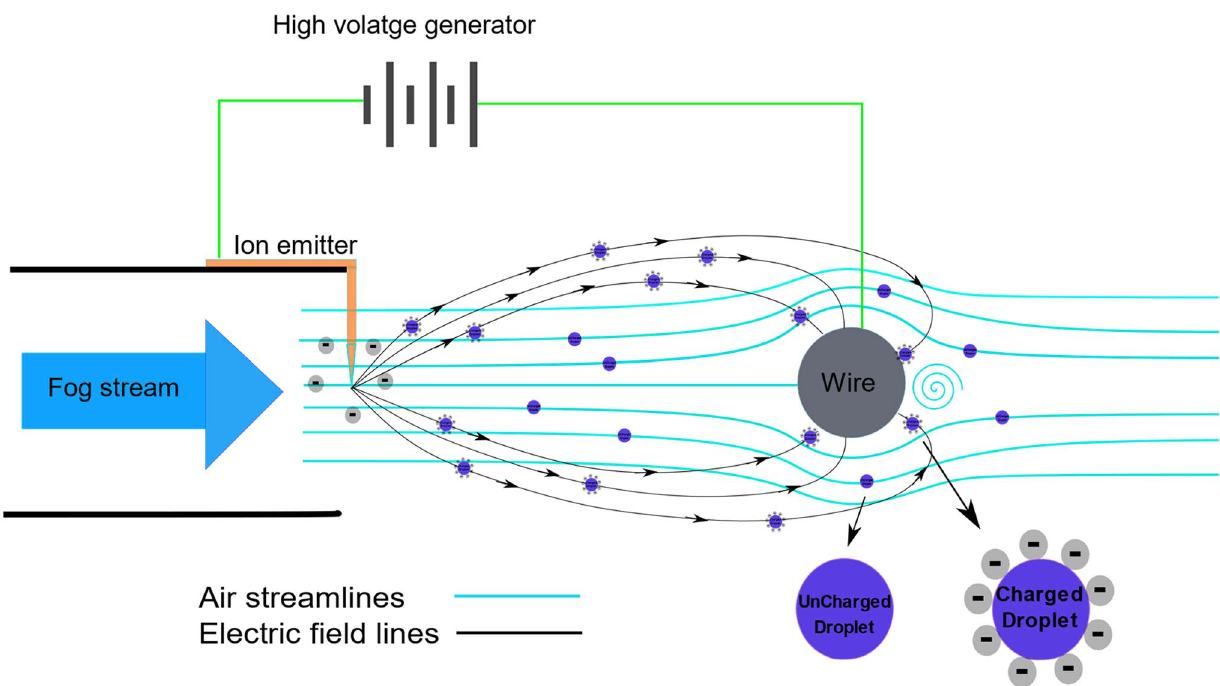
Fig. 6 A schematic of the air streamlines and electric field lines for the fog collecting